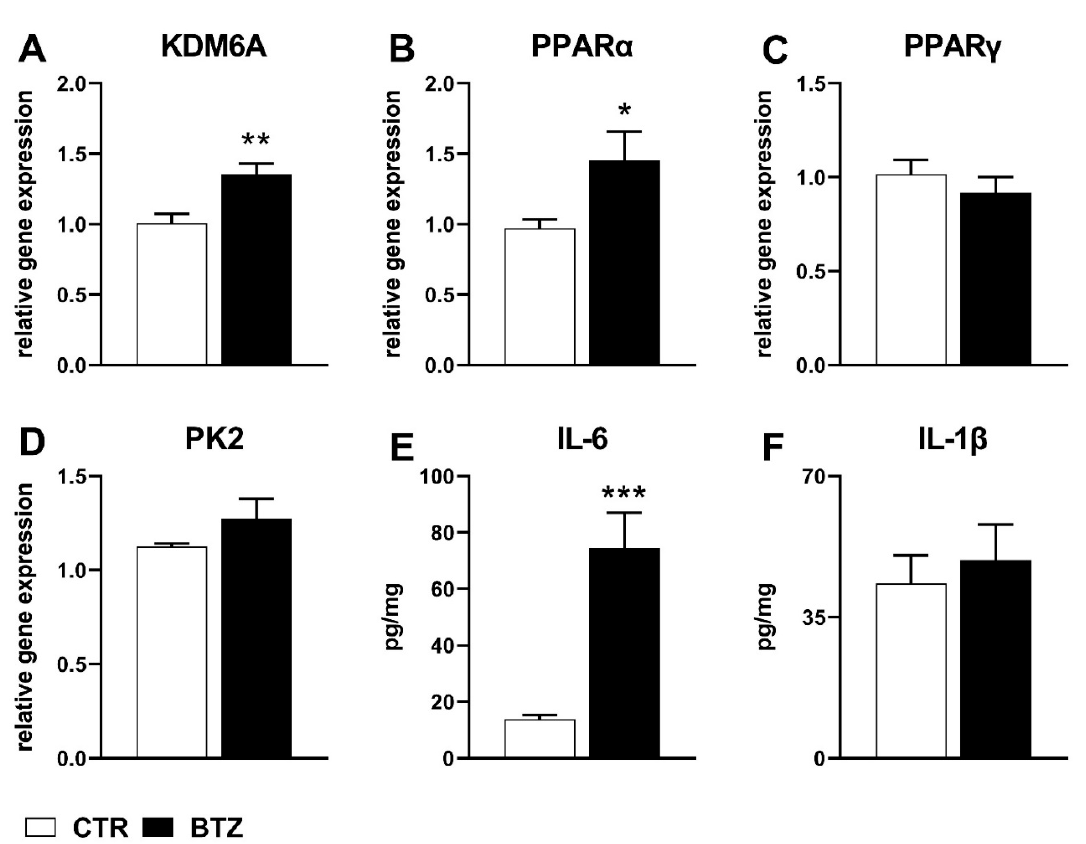
Figure 2. Spinal cord biochemical alterations assessed at the day 14 after BTZ treatment (0.4 mg/kg, 3 times/week for two weeks). ( A – D ) mRNA levels determined by qPCR for KDM6A, PPAR α , PPAR γ , and PK2. ( E , F ) protein levels determined by ELISA for IL-6 and IL-1 β . Data are expressed as mean ± SEM of six mice/group (* p < 0.05; ** p < 0.01; *** p < 0.001 vs. CTR; analyzed by t-test).